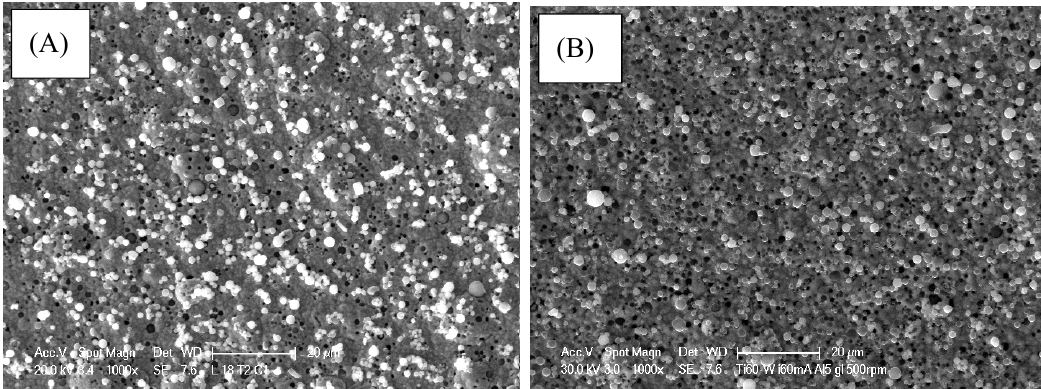
Figure 6. Surface morphology of coatings obtained at the temperature of 40 °C, Al content in the bath of 5 g/L, stirring rate of 500 rpm, and different current densities: ( A ) 30, and ( B ) 60 mA/cm 2 .